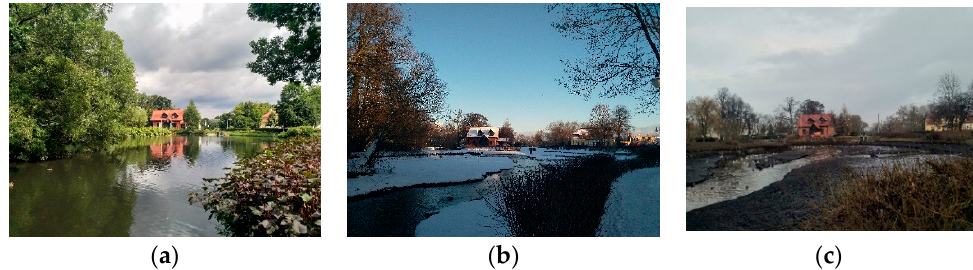
Figure 6. The reconstructed pond seasonal changes in water level ( a ) during summer ( b , c ) winter. Source: author.